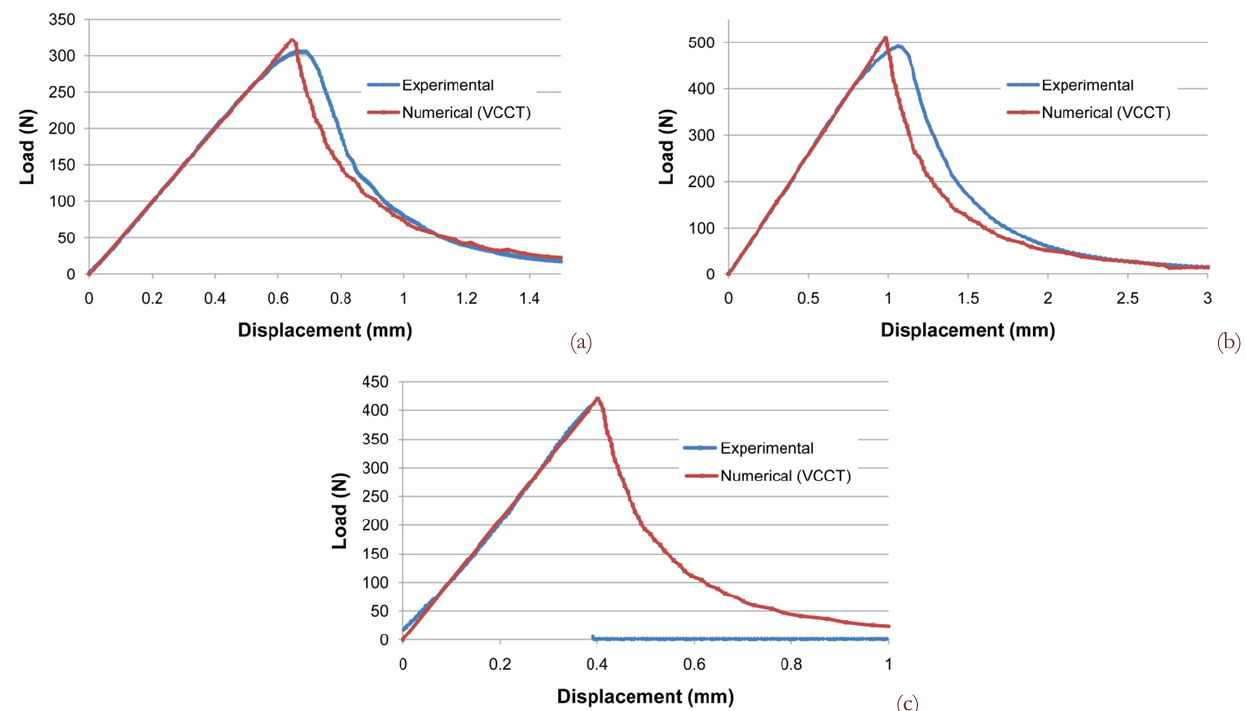
Figure 12: Numerical and experimental load-displacement curves for (a) adhesive 2015 non modified; (b) adhesive AW106 with 25wt% TEMs; (c) adhesive AV138 with 20wt%